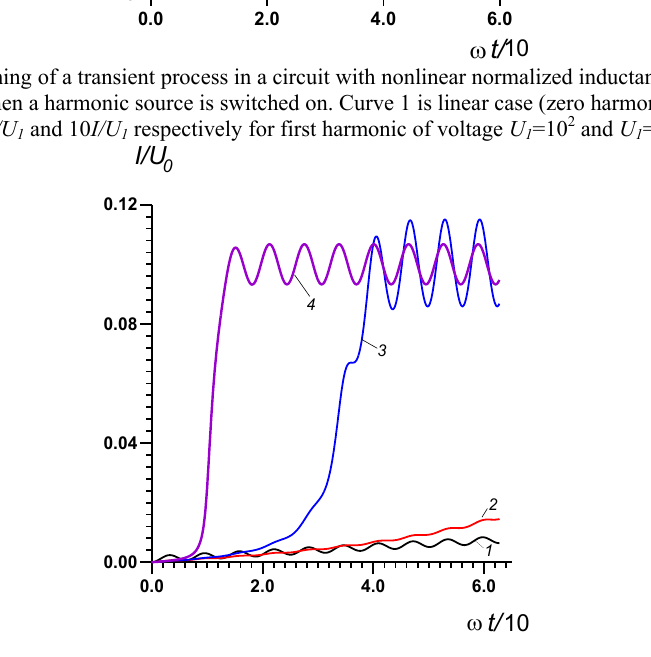
Fig. 5. Establishing of a transient processes for a nonlinear circuit with U 1 = 10 : U 0 = 10 (curve 1), U 0 =10 2 (2), U 0 = 3  10 2 (3), U 0 =10 3